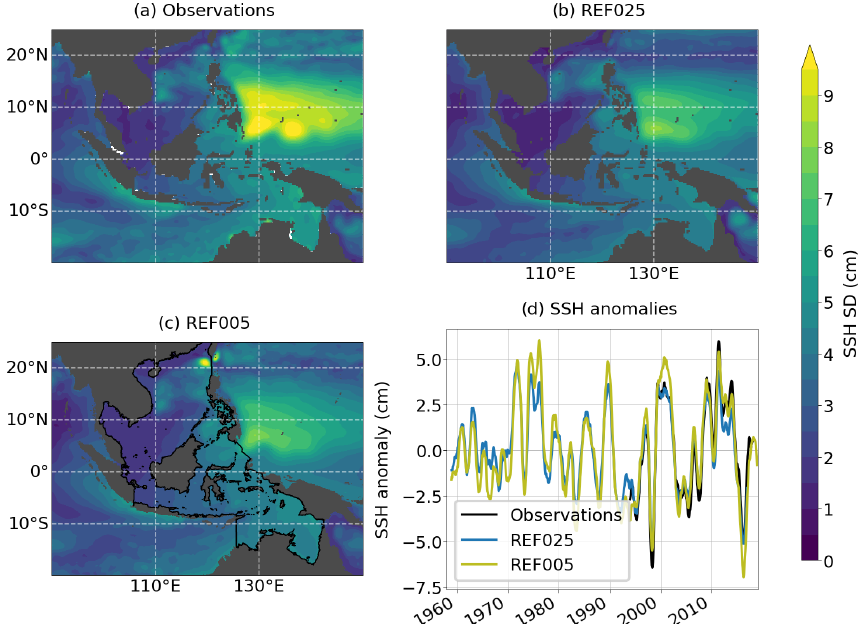
Figure 2. SD of SSH from (a) observations and two hindcast experiments, (b) REF025 and (c) REF005, over the period 1993 to 2016. (d) SSH anomalies averaged over the region marked by black contours in panel (c) . The global mean trends over the integration period have been subtracted, and all data were smoothed with a 12-month running mean window.